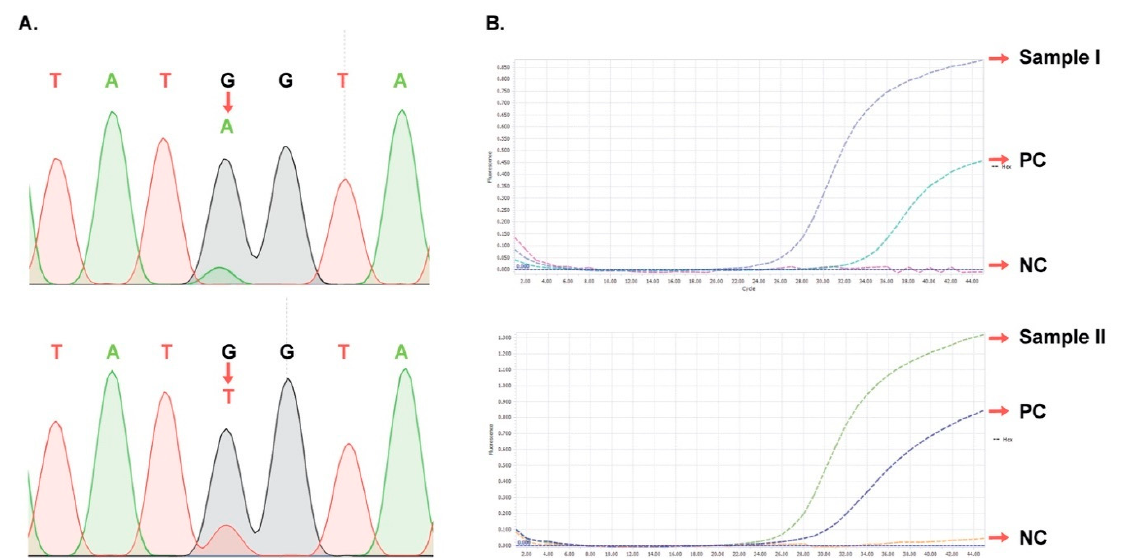
Figure 4. Detection of mt rtV207I (G750A) and mt rtV207I (G750T) in two clinical samples by COLD-PCR combined DNA sequencing and then confirmation by real-time PCR using an Lock Nucleic Acid (LNA) probe: ( A ) DNA sequencing chromatograms for samples I and II carrying the mt rtV207I (G750A) (upper panel) and mt rtV207I (G750T) (lower panel), respectively. The red arrows are the positions of mutated bases. ( B ) Fluorescent real-time PCR amplification curves of samples I and II (upper panel) and of sample II (lower panel), respectively. PC, positive control (5% mt / wt); NC, negative control (wt only).